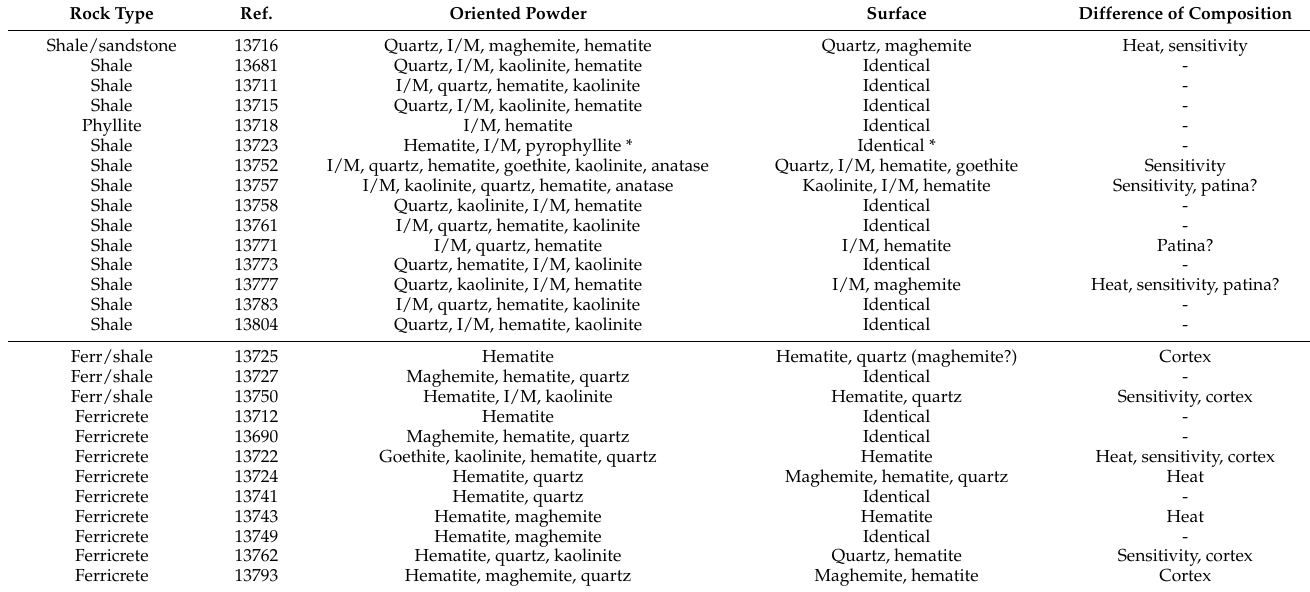
Table 6. Comparison between non-invasive analyses on cohesive pieces and invasive analyses on oriented powders by XRD for archeological samples. Legend—*: proxy for geological origin; in bold: main phase detected.